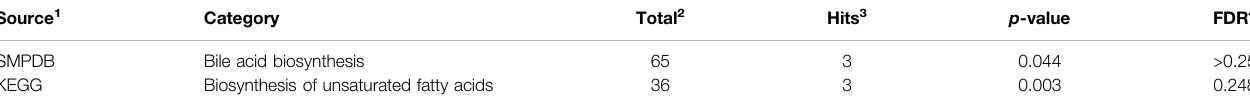
TABLE 4 | Pathways enriched at p -value < 0.05 and including at least three metabolites among the molecules associated with maternal immune activation effects. Source 1